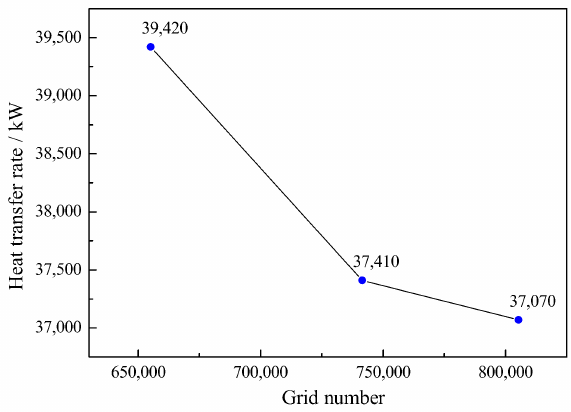
Figure 9. Grid independence